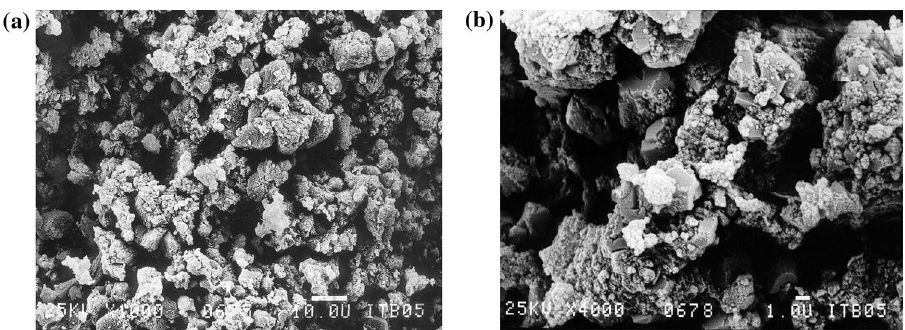
Figure 1. Crystalline structure of lime-softening sludge (SEM), magnified: ( a ) 1000 times and ( b ) 4000